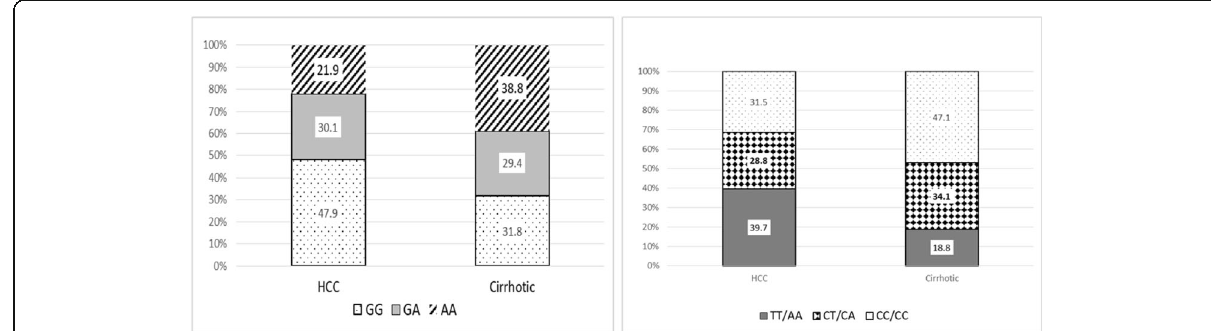
Fig. 1 Genotype distribution among the studied